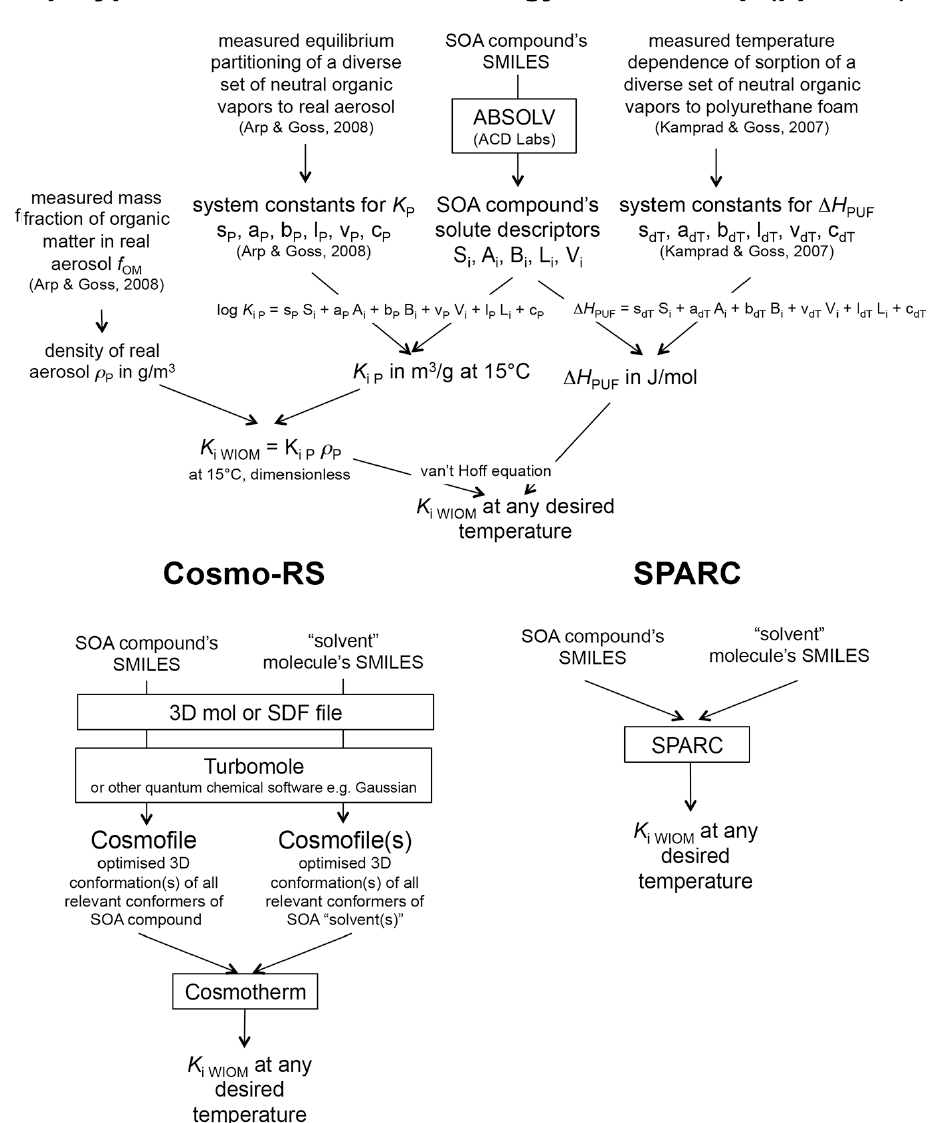
Figure 3. Outline of the three methods for estimating K i, WIOM